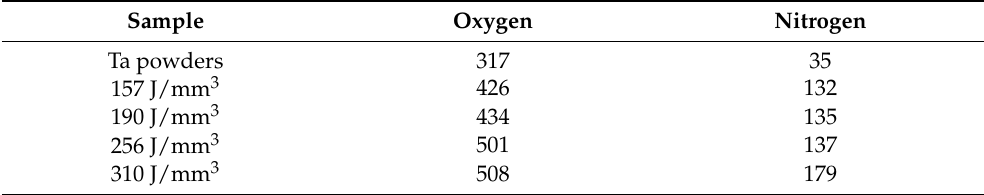
Table 4. Contents of oxygen and nitrogen impurities in the raw powders and the SLMed Ta. (Unit: